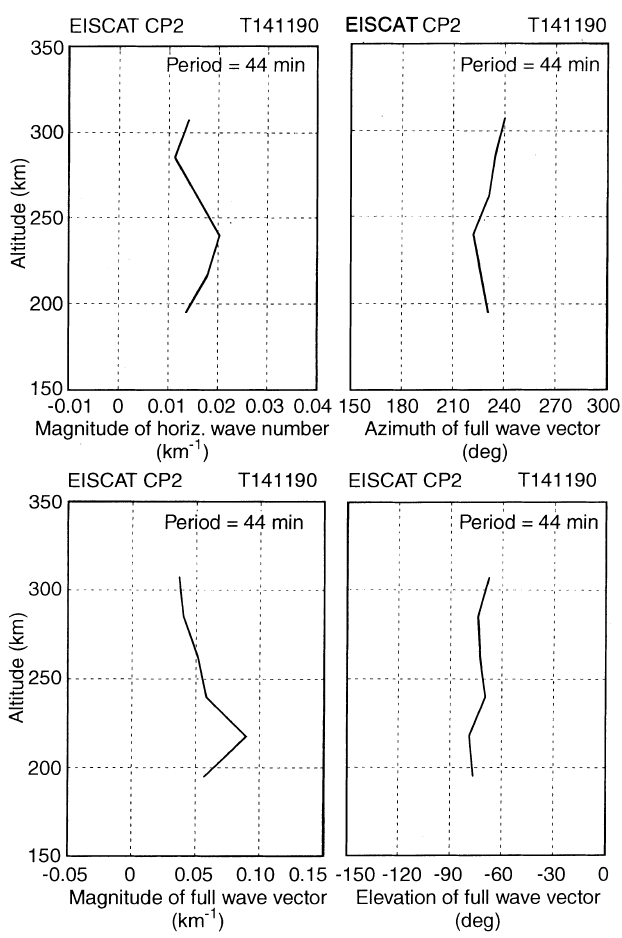
Fig. 8. Height dependent apparent full wave vector of the N e -TID with a wave period of 44min. Upper left panel : magnitude of the horizontal wave vector; upper right panel : azimuth of the full wave vector; lower left panel : magnitude of the full wave vector; lower right panel : elevation angle of the full